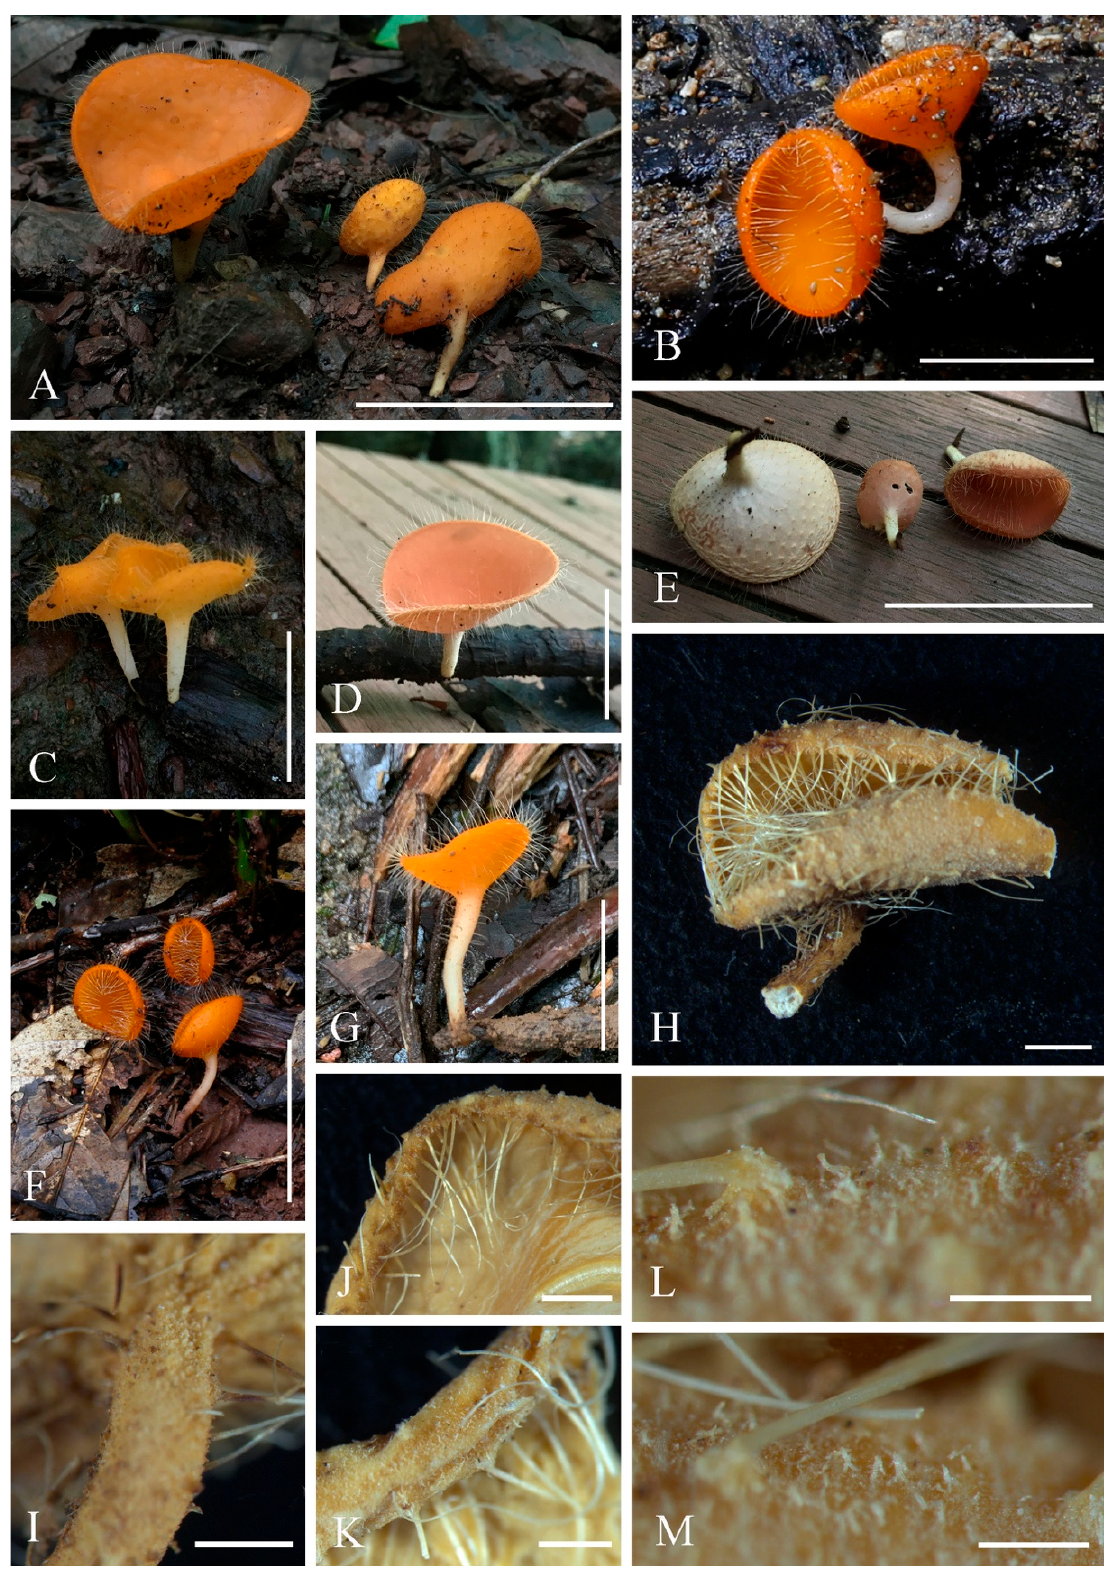
Figure 5. Cookeina sinensis . ( A – G ) Fresh apothecia [( A ) HKAS 121177. ( B ) HKAS 121176. ( C ) HKAS 121178. ( D , E ) HKAS 121179. ( F ) HKAS 121175. ( G ) MFLU 21 ‐ 0155.] ( H ) Dry apothecium (HKAS 121175). ( I ) Stipe (HKAS 121175). ( J ) Compound hairs (HKAS 121177). ( K ) Margin (HKAS 121178). ( L , M ) Receptacle surface of an apothecium (HKAS 121175). Scale bars ( A , E , F ) = 5 cm; ( B – D , G ) = 3 cm; ( H , J ) = 2000 μ m; ( I , K ) = 1000 μ m; ( L , M ) = 500 μ m.